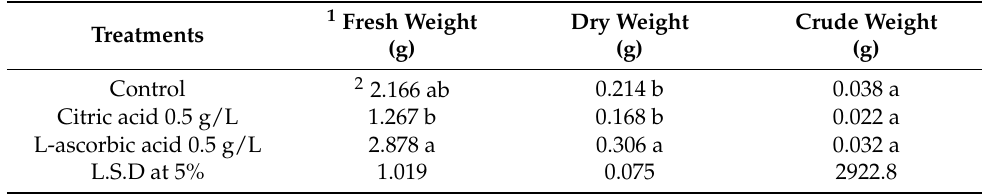
Table 1. The effect of bio-elicitors on R. damascena callus development and total crude weight.